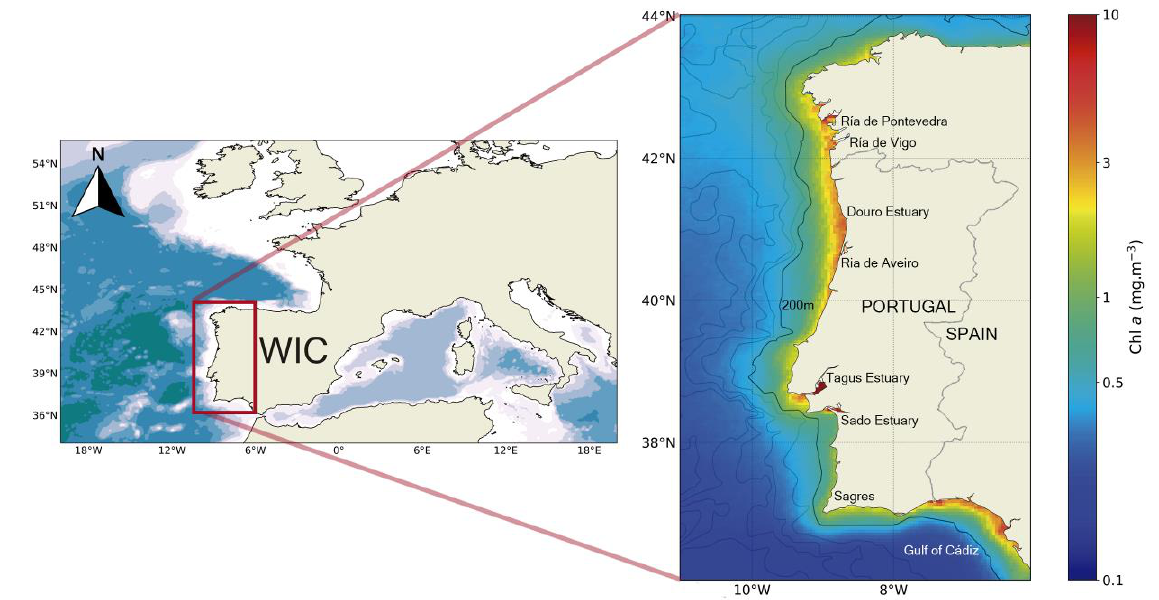
Figure 1. Location of the Western Iberian Coast (WIC) and mean satellite chl- a concentration during 1997–2019. Black lines correspond to isobathymetric lines at 200 m, 1000 m, 2000 m, 3000 m, 4000 m, 5000, and 6000 m depths. Note that the background color in the left plot represents oceanic bathymetry.